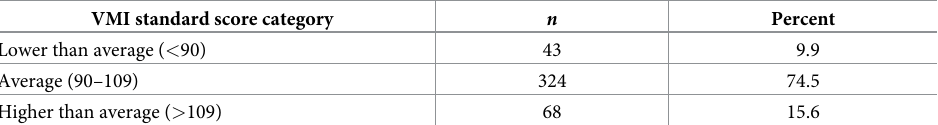
Table 4. Distribution of VMI standard scores based on three categories: Lower than average, average, and higher than